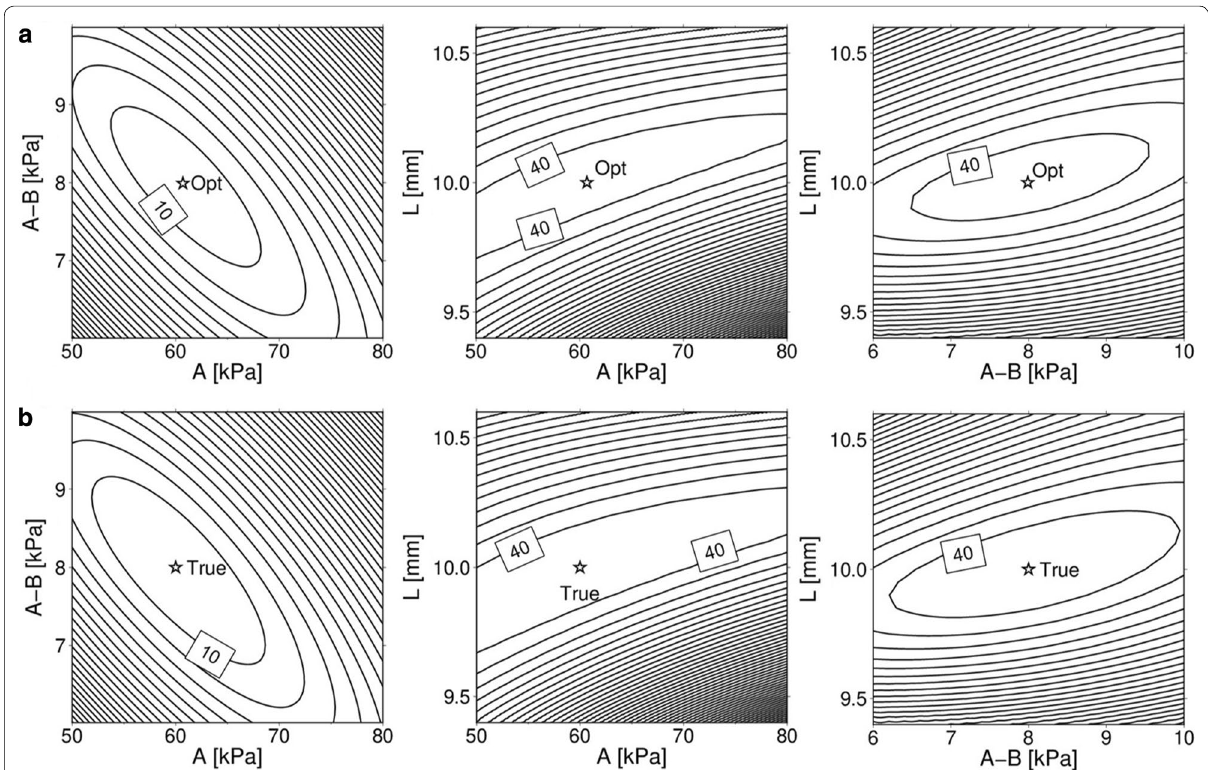
Fig. 14 Two-dimensional contour maps of the cost function when slip velocities are assimilated. Cost functions are calculated as functions of ( A